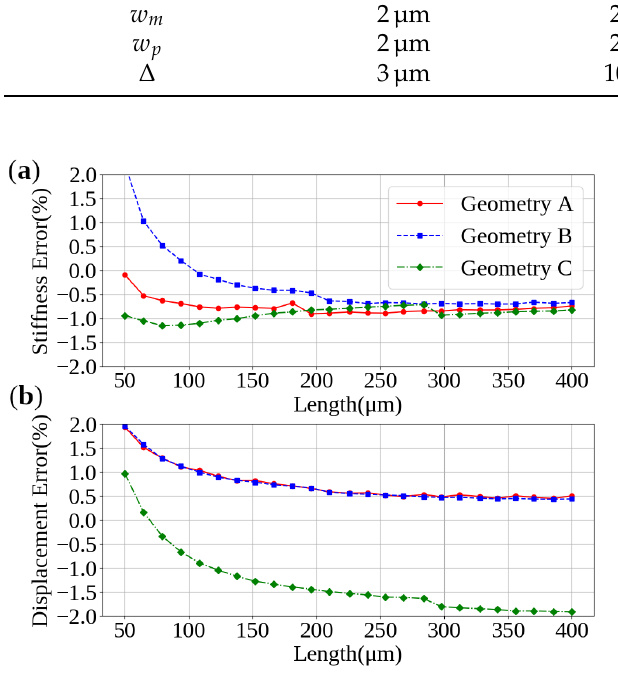
Figure 4. Percent error for: ( a ) stiffness and ( b )